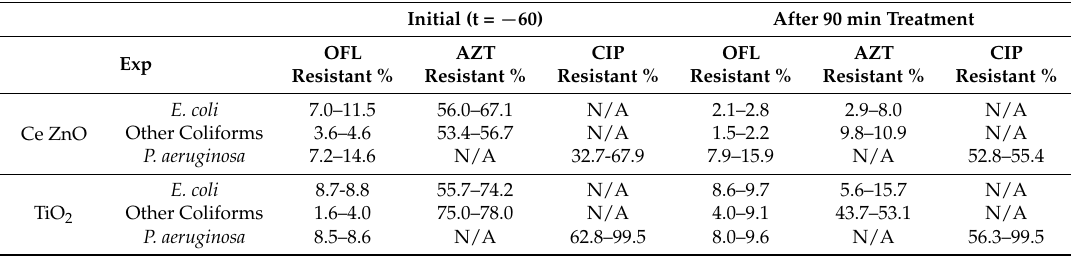
Table 2. Resistant fractions ± SD after 90 min of treatment with Ce-ZnO and TiO 2 .